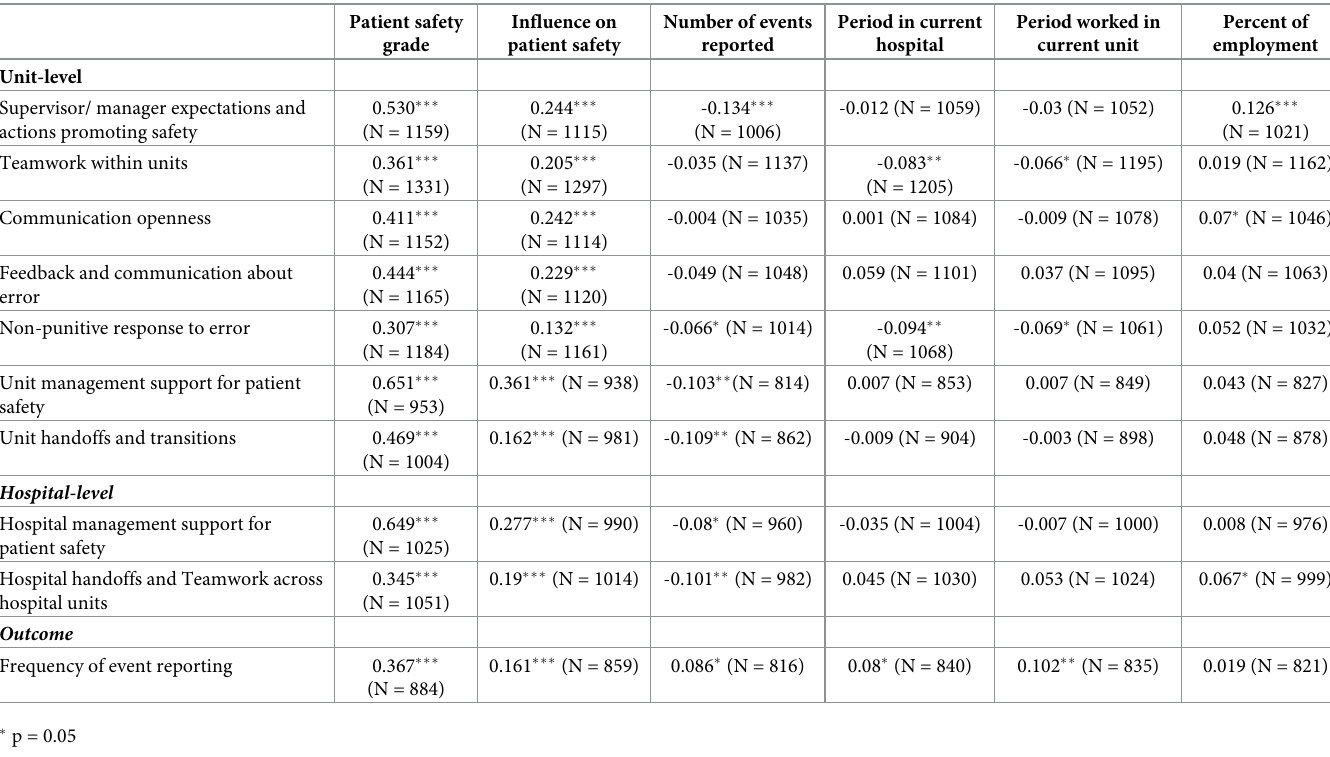
Table 5. Inferential statistics with original 10